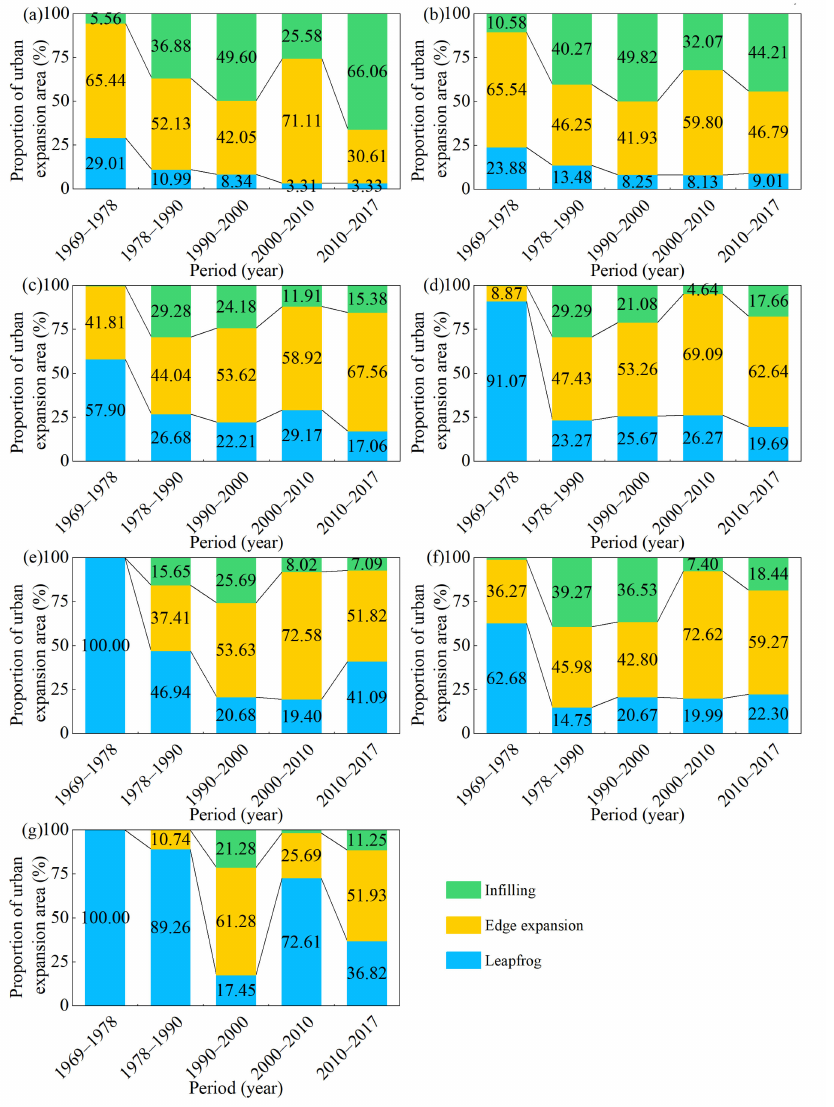
Figure 5. Urban expansion model at different altitudes. ( a ) 2100–2200 m; ( b ) 2200–2300 m; ( c )